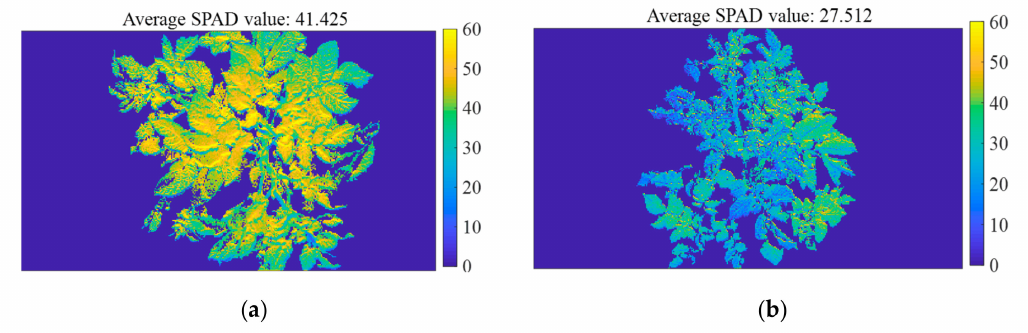
Figure 13. The visualization distribution map of potato plant at two growth stages. ( a ) tuber formation stage; ( b ) tuber expansion stage.